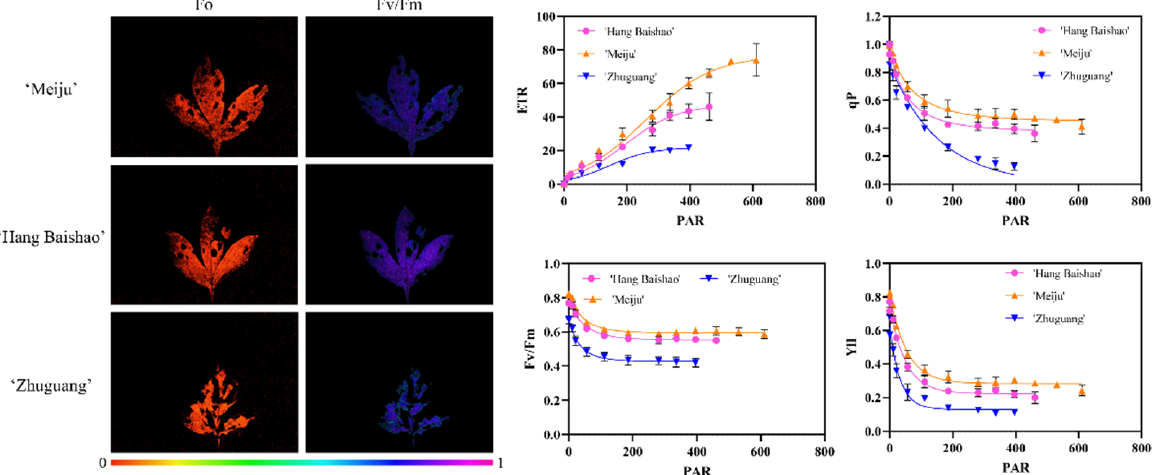
Figure 5. Chlorophyll fluorescence imaging screens of the selected adaptive and maladapted cultivars under summer heat stress in 2021. The fluorescence color indicates the Fo and Fv/Fm values. Data expressed in the figure represents the mean ± standard deviation of three replicates.